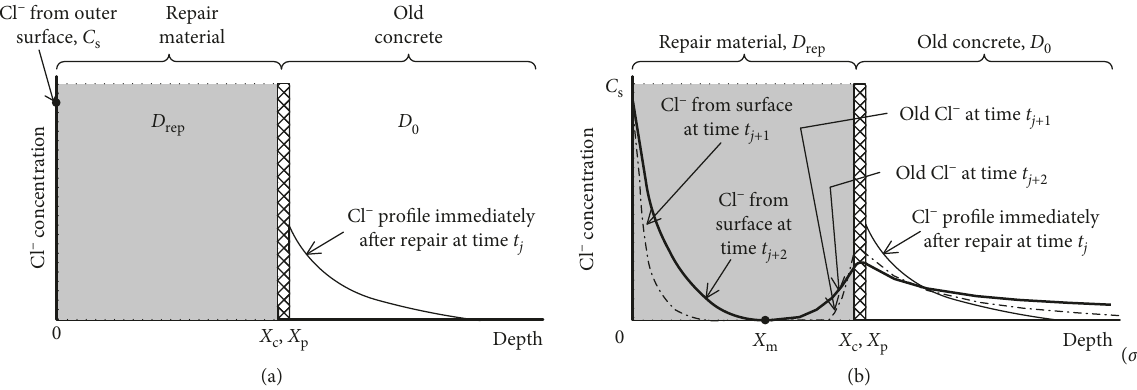
Figure 2: Chloride profiles after cover concrete replacement. (a) Immediately after repair. (b) After